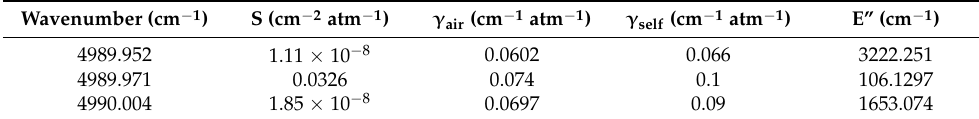
Table 2. Spectroscopic parameters for the selected CO 2 transition near 4989.97 cm −1 (298 K).